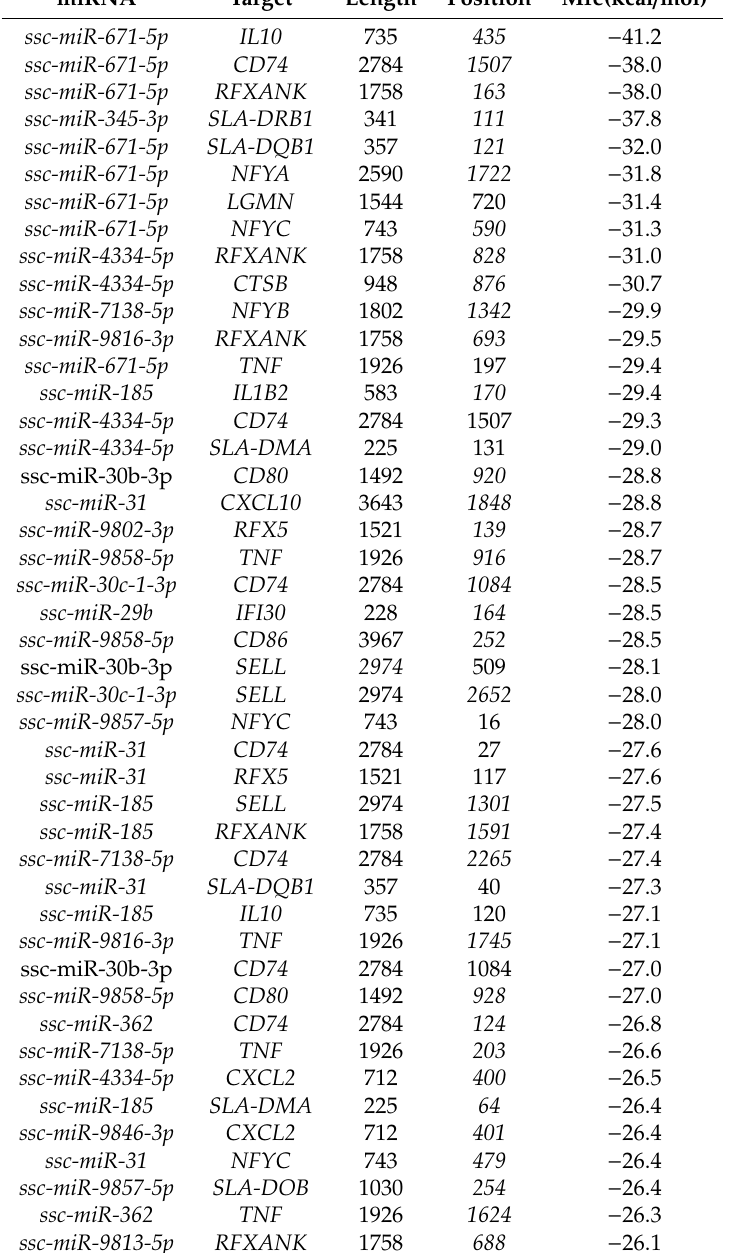
Table1. InsilicopredictionofmiRNA-mRNA3’UTRhybridizationreactions. mfe: